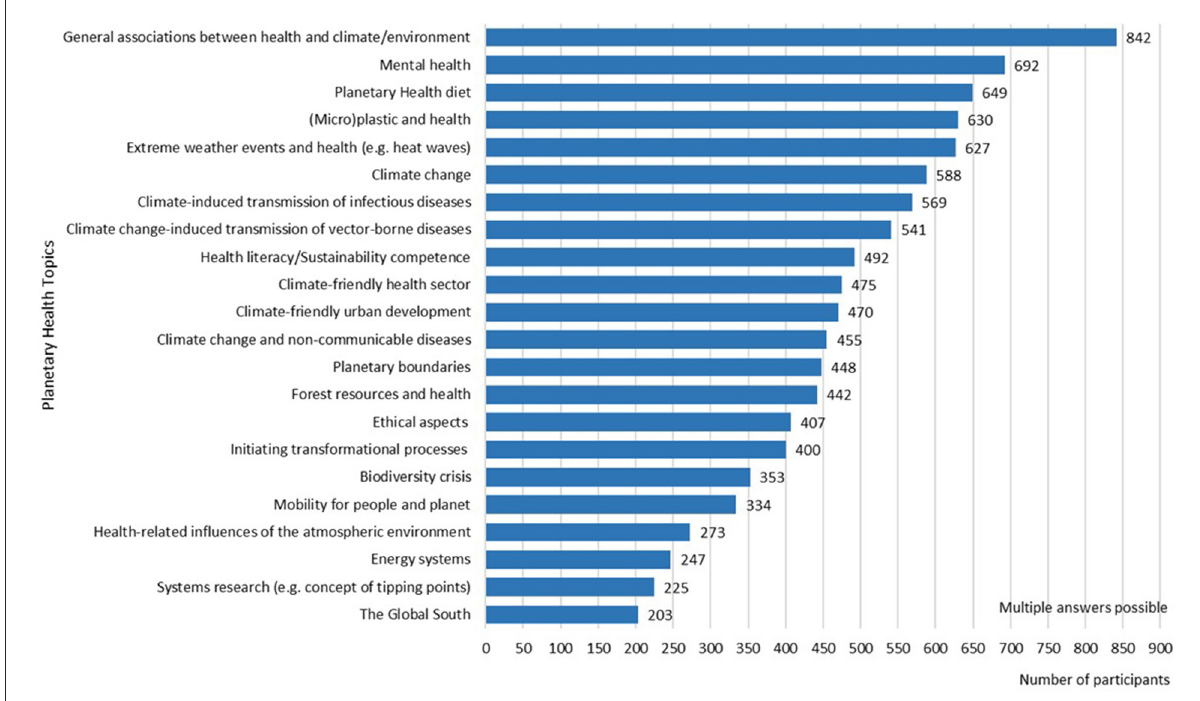
FIGURE3 Participants’ interest in Planetary Health topics ( N =